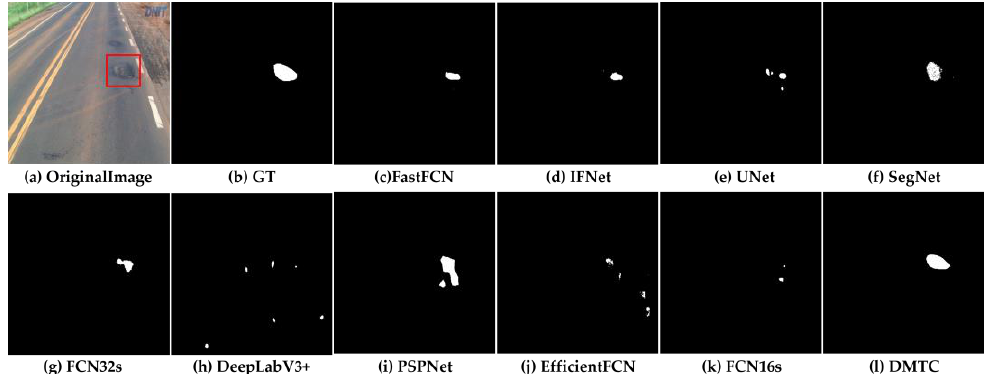
Figure 6. Visual comparison of the results of a series of segmentation methods for small potholes on CPRID. There is a red outline around the pits in the original image, a white outline around the pits in the label map and segmentation map, and black in the rest of the background.